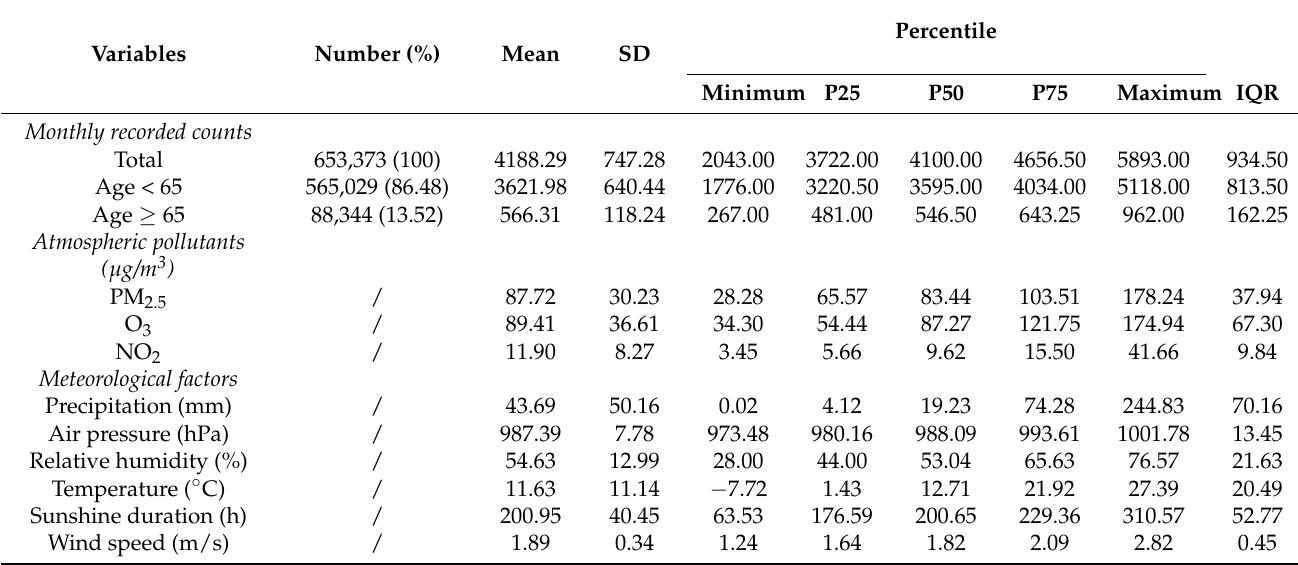
Table 3. Summary statistics of the number of pulmonary tuberculosis (PTB) cases, air pollutant concentrations, and meteorological factors in the Beijing–Tianjin–Hebei region.